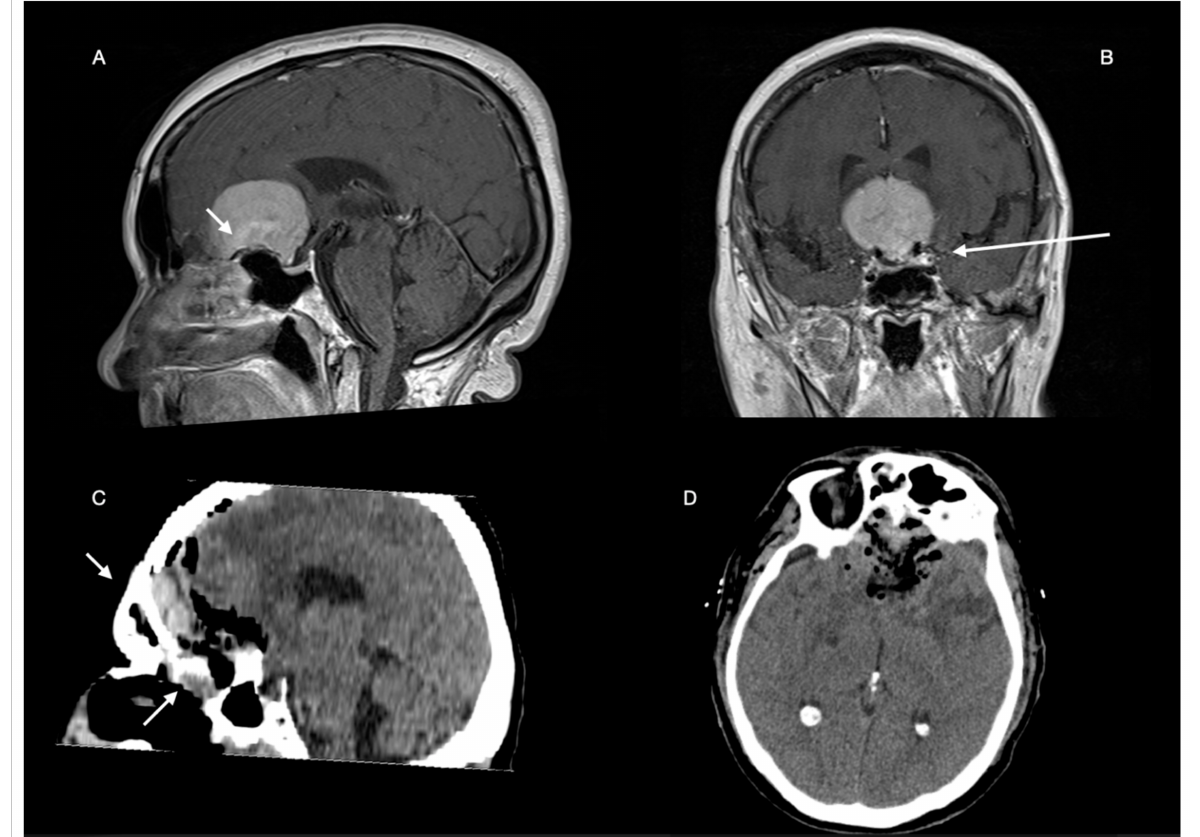
Figure 11. We present a case of a 66-year-old woman with frontobasal meningioma. On MRI ( A , B ), there is partial bilateral encasement of the anterior cerebral arteries and partial erosion of the floor of the anterior cranial fossa (white arrows). Surgical excision resulted in partial inferior residual and compromised anterior fossa floor (white arrows, C , D ). The patient after an initial postoperative recovery showed rhinoliquorrhea after about 4 days, which was subsequently treated